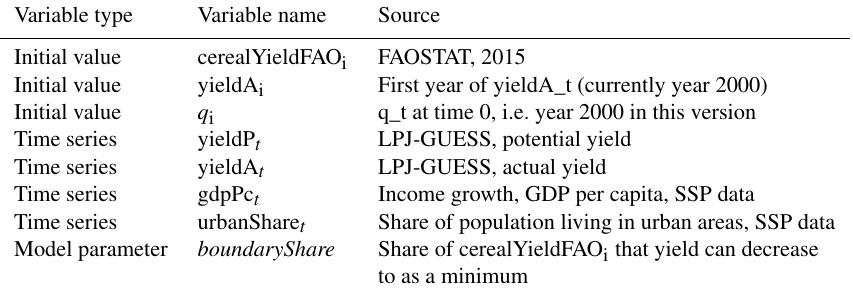
Table A2. Yield-related variables in